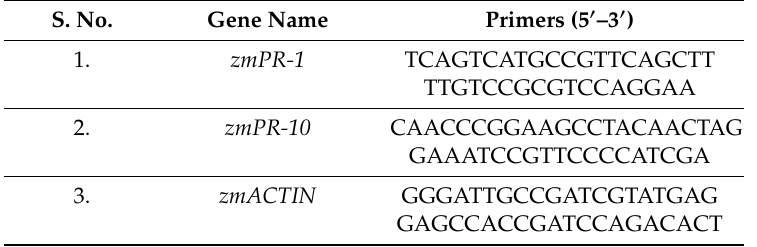
Table 1. Primers used for qRT-PCR in the gene expression